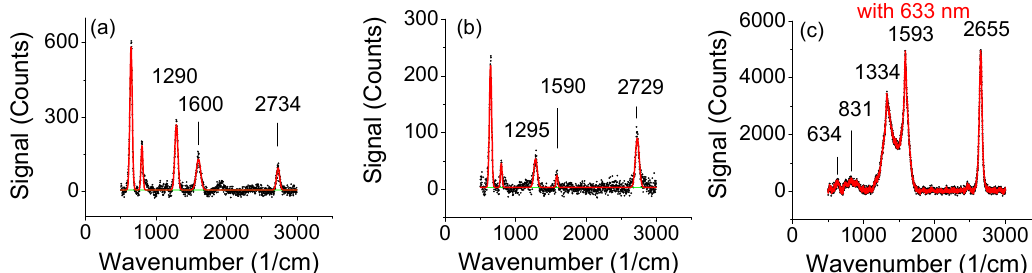
Figure 4. ( a ) 10-nm alumina-graphene on a 25 micron Cu foil. ( b ) 10-nm hafnia-graphene on 25 micron Cu foil. The two lines below 1000 1/cm belong to the Cu foil itself. The 1290 1/cm is the defect D line when exposed to the 442 nm laser line. Local stresses and differences between two- and one-layer graphene may have contributed to the graphene’s line shifts towards the higher frequencies in (a) vs (b). ( c ) Same sample as (a); 10-nm alumina-graphene on a 25 micron Cu foil measured with 633 nm HeNe